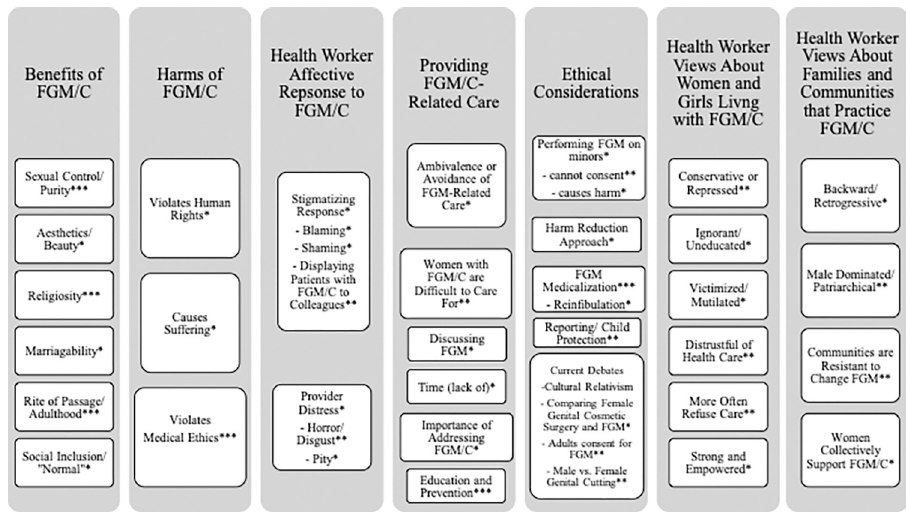
Fig 2. Attitudes: Categories and codes. * All Settings, ** Low Prevalence, *** High Prevalence.